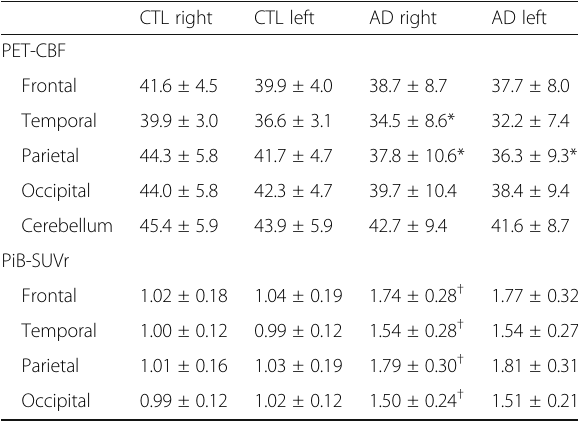
Table 2 Regional PET-CBF (mL/min/100 g) and SUVr values (mean ± SD) CTL right CTL left AD right AD left